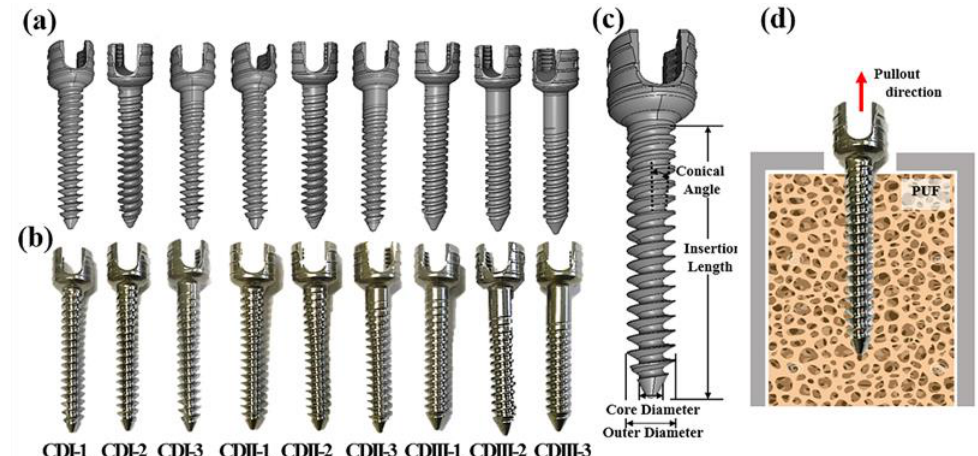
Figure 3. ( a ) Pedicle screw 3D model, ( b ) products, ( c ) parameters of pedicle screw and ( d ) schematic diagram of pullout test.